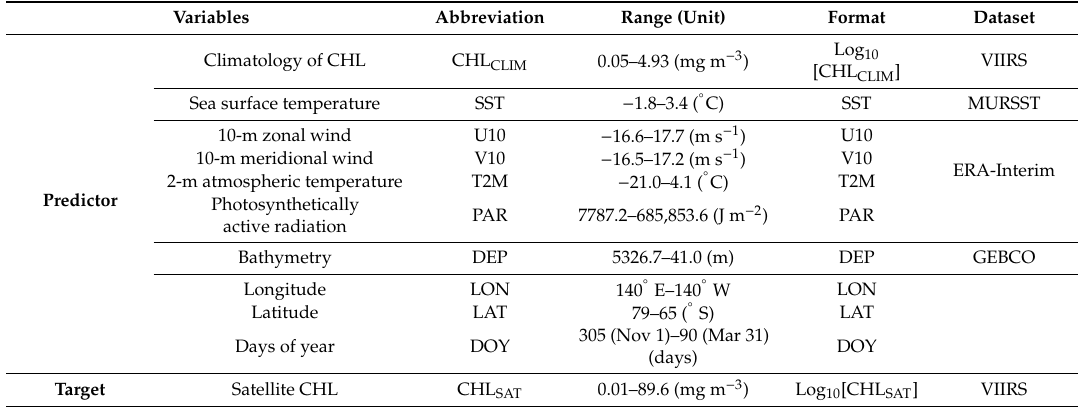
Table 1. Information on the datasets used for the chlorophyll-a concentration (CHL) reconstruction model development. All data were bilinearly remapped into the resolution (9 km) on the visible infrared imaging radiometer suite (VIIRS) CHL